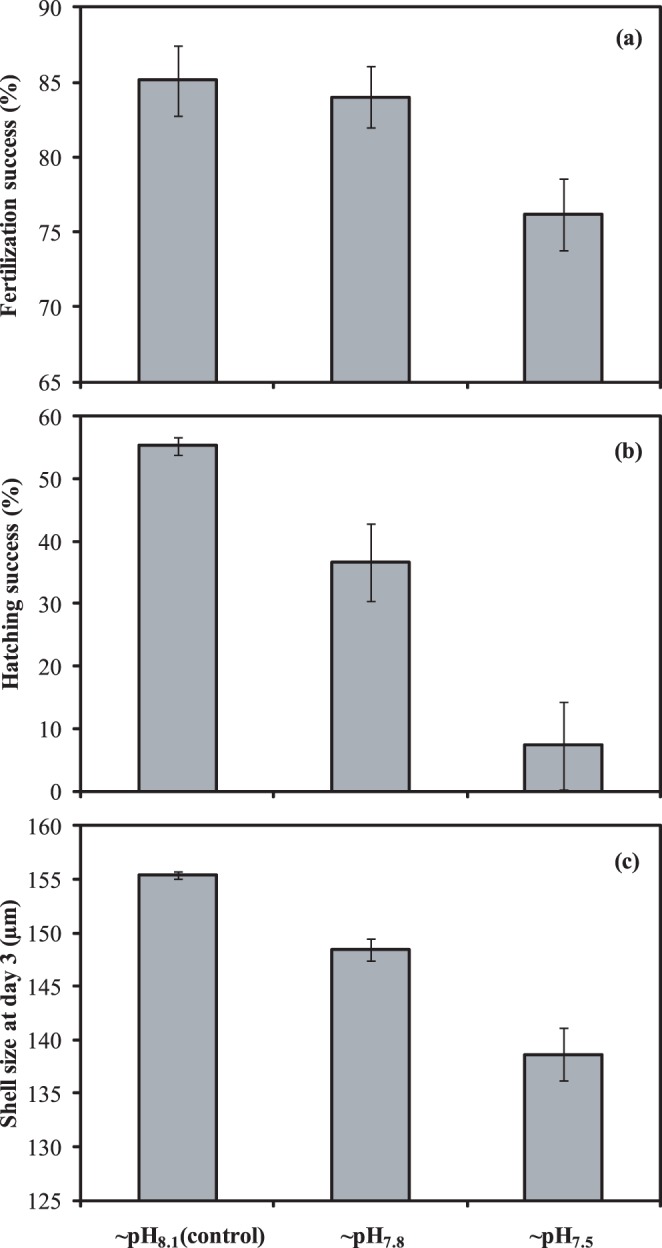

Macoma balthica: Ocean acidification effects on fertilization and embryogenesis.(a) fertilization success, (b) hatching success, and (c) size of larvae that have developed a shell after 3 days, reared at three pH conditions: control (∼pH8.1), ∼pH7.8 and ∼pH7.5. Level of replication: n = 5 for fertilization success, n = 3 for hatching success and size. Presented error bars are standard errors.